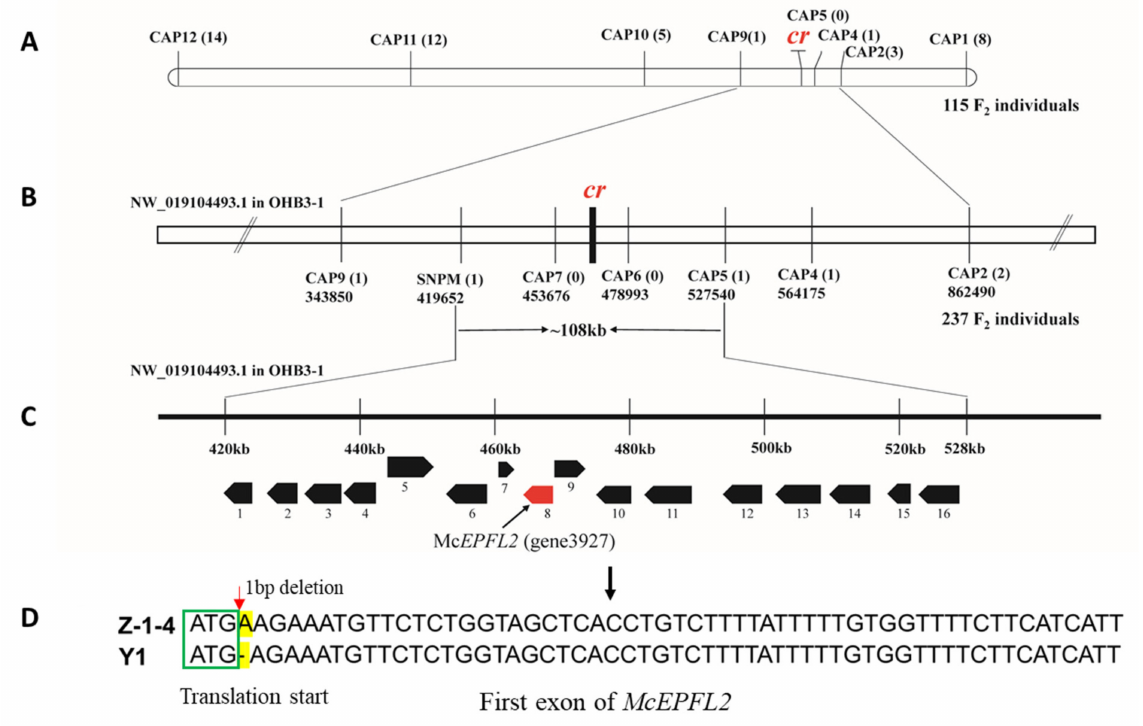
Figure 3. Fine genetic mapping of cr locus. ( A ) Initial mapping in 115 F2 plants placed the cr locus in a ~210 kb region on scaffold NW_019104493.1 in OHB3-1. Numbers in brackets after the name of markers are recombinants. The cr candidate region is further narrowed down to 108 kb region ( B ) that harbors 16 predicted genes ( C ). Gene # 8 (red) encodes the EPIDERMAL PATTERNING FACTOR 2 protein ( McEPFL2 ), which is the best candidate for cr . A 1 bp deletion is present in the first exon of McEPFL2 of the inbred line Y1 with CR ( D